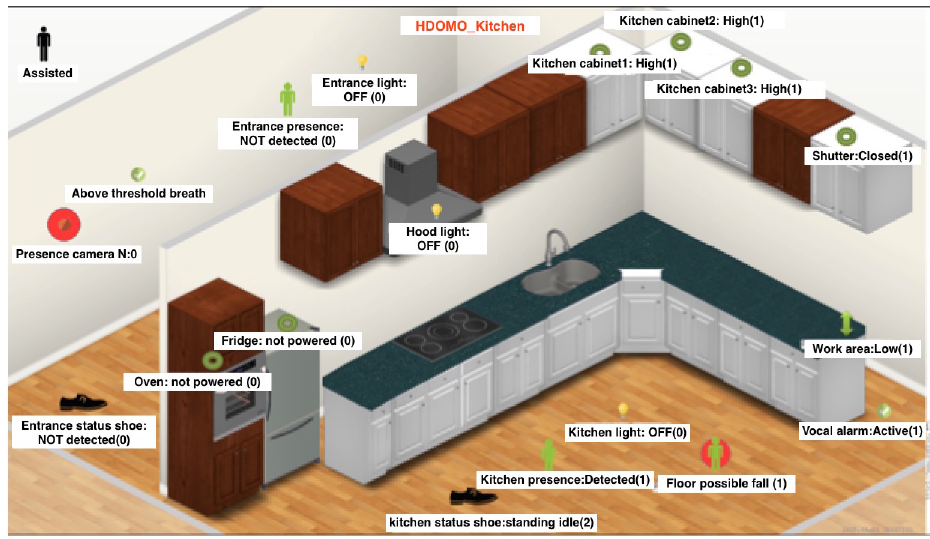
Figure 25. Example of a HDOMO